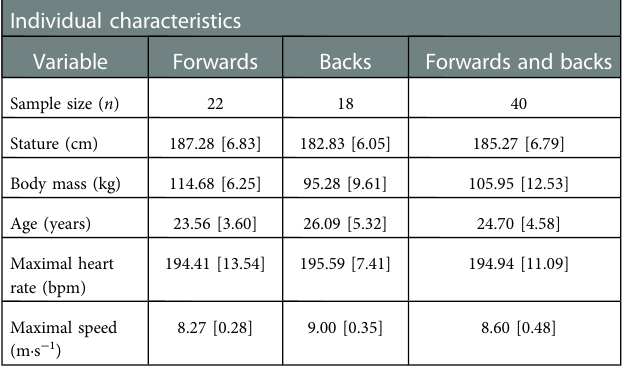
TABLE 1 Individual characteristics for the participants of the study. Individual characteristics